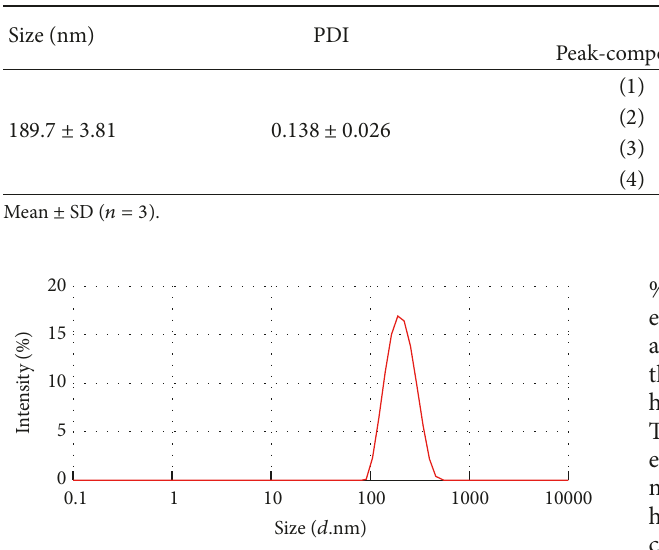
Figure 3: Size distribution of HFL loaded NP measured by the DLS technique.